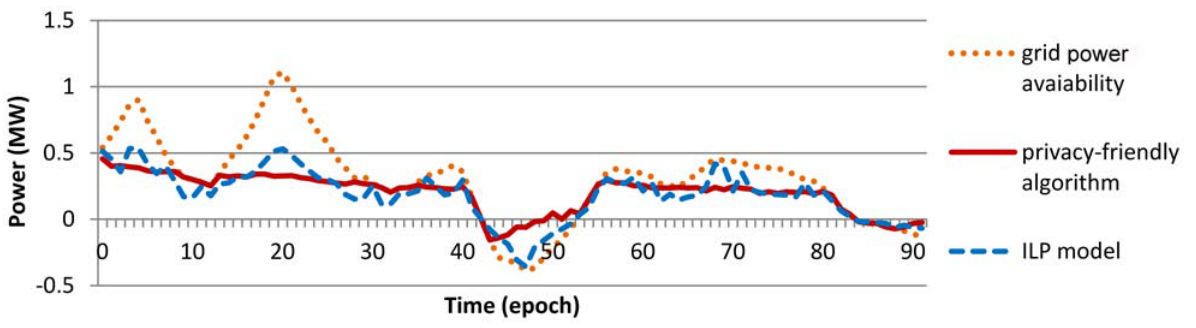
Figure 3. Comparison of optimal vs. privacy-friendly scheduled battery charges/discharges. Positive values indicate that the grid provides power to recharge the EVs’ batteries, while negative values indicate that power provided by the batteries is injected into the grid.